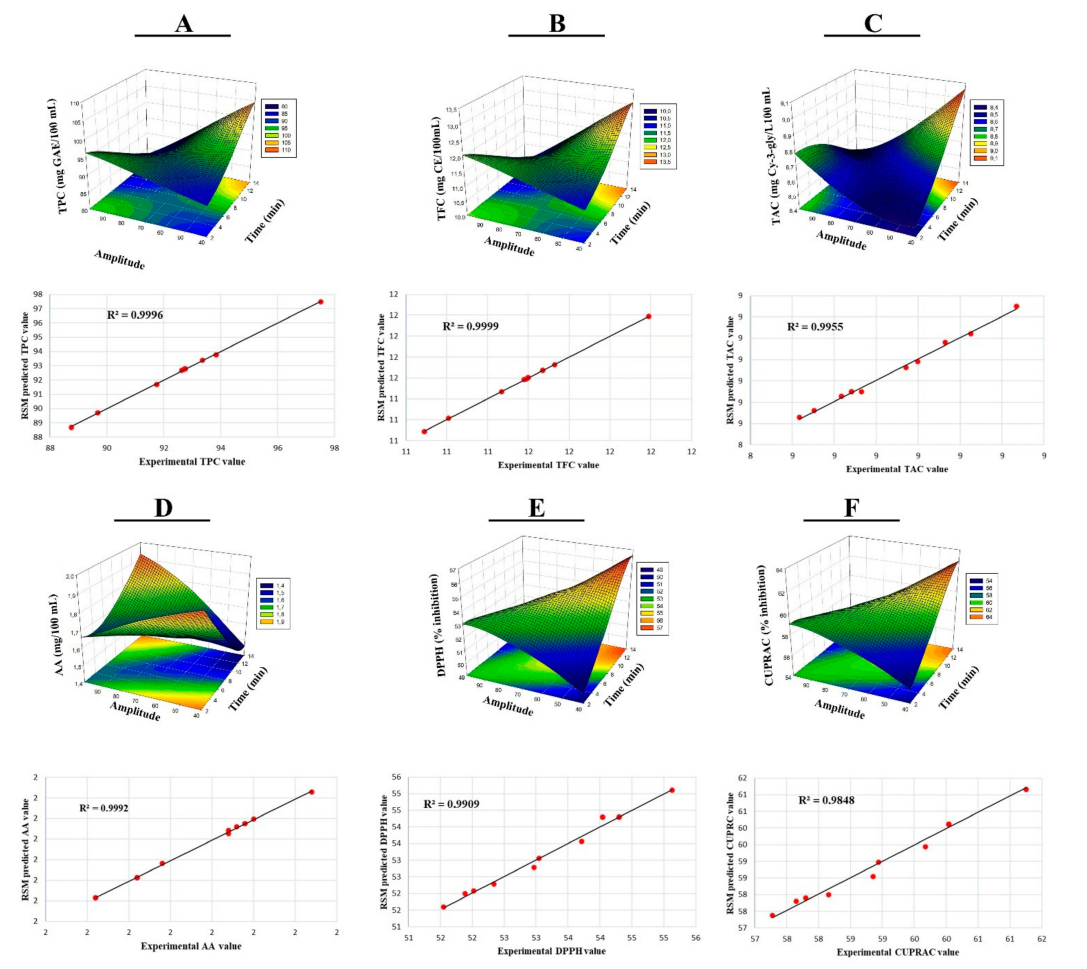
Figure 1. Response surface plots (3D) and linear regression of TPC ( A ), TFC ( B ), TAC ( C ), AA ( D ), DPPH ( E ), and CUPRAC ( F ), as functions of significant interaction